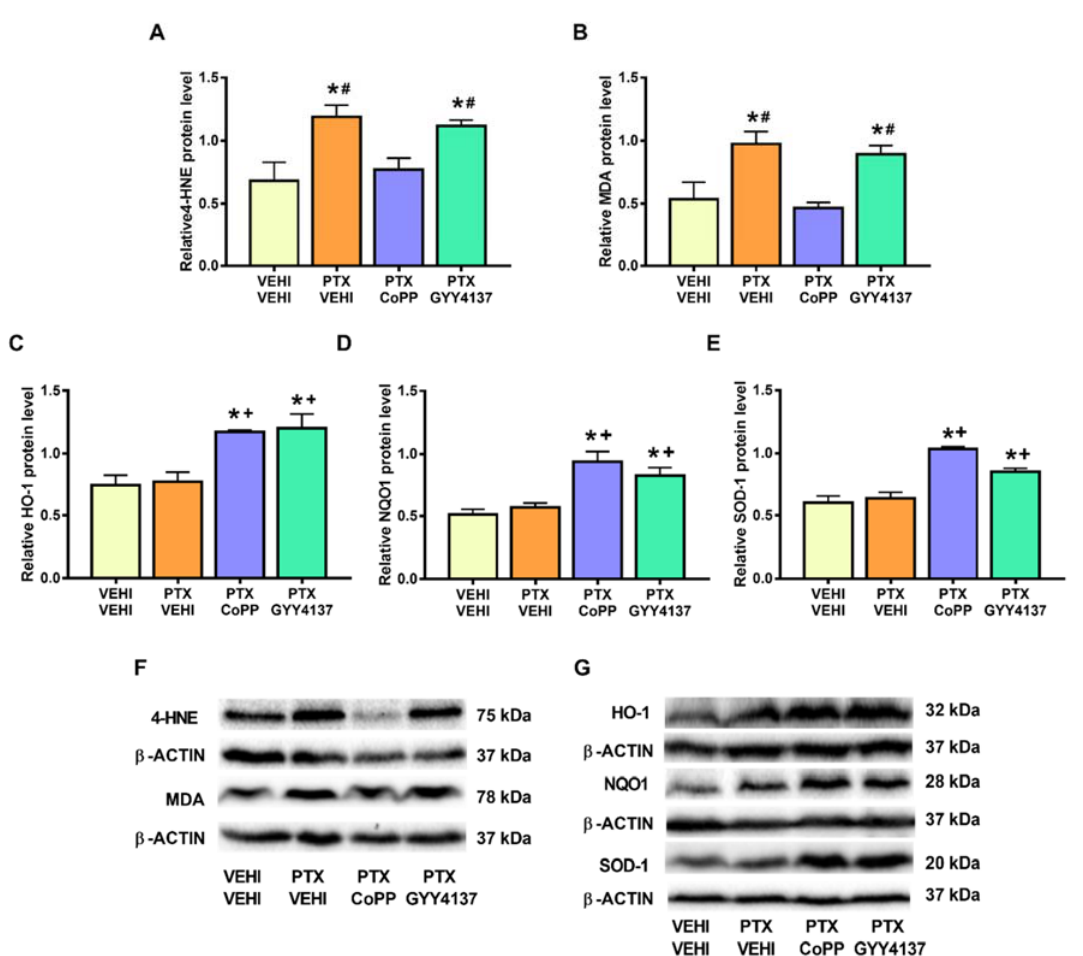
Figure 8. Effects of CoPP and GYY4137 on the levels of 4-HNE, MDA, HO-1, NQO1, and SOD1 in the PFC of PTX-injected mice. Graphs represent the levels of 4-HNE ( A ), MDA ( B ), HO-1 ( C ), NQO1 ( D ), and SOD-1 ( E ) in the PFC of PTX-injected animals treated with CoPP or GYY4137. The control group treated with VEHI–VEHI is also represented. Representative blots for 4-HNE and MDA ( F ) and for HO-1, NQO1, and SOD1 ( G ) are shown. All proteins are represented relative to β -actin levels. In all panels, * indicates significant differences vs. the VEHI–VEHI-treated mice; +, vs. animals treated with PTX–VEHI; and #, vs. the PTX–CoPP treated mice ( p < 0.05, one-way ANOVA followed by the SNK post hoc test). Data are expressed as mean values ± SEM; n = 3 samples per group.